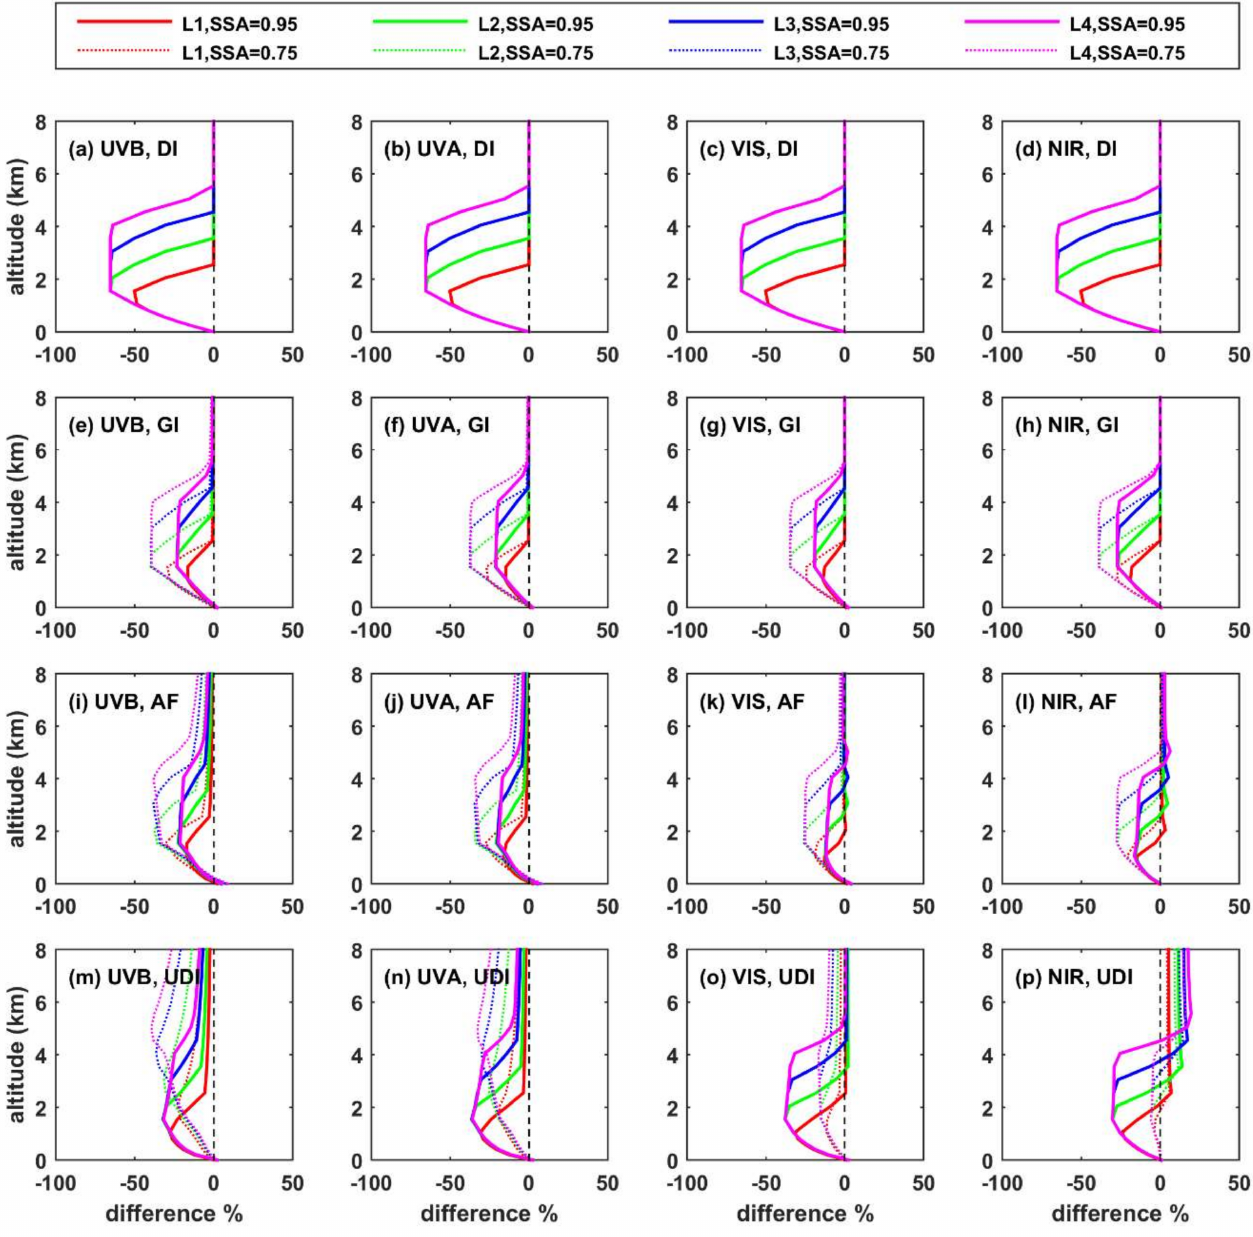
Figure A3. Same as Figure 3, but for SZA = 20 ◦ instead of SZA = 60 ◦